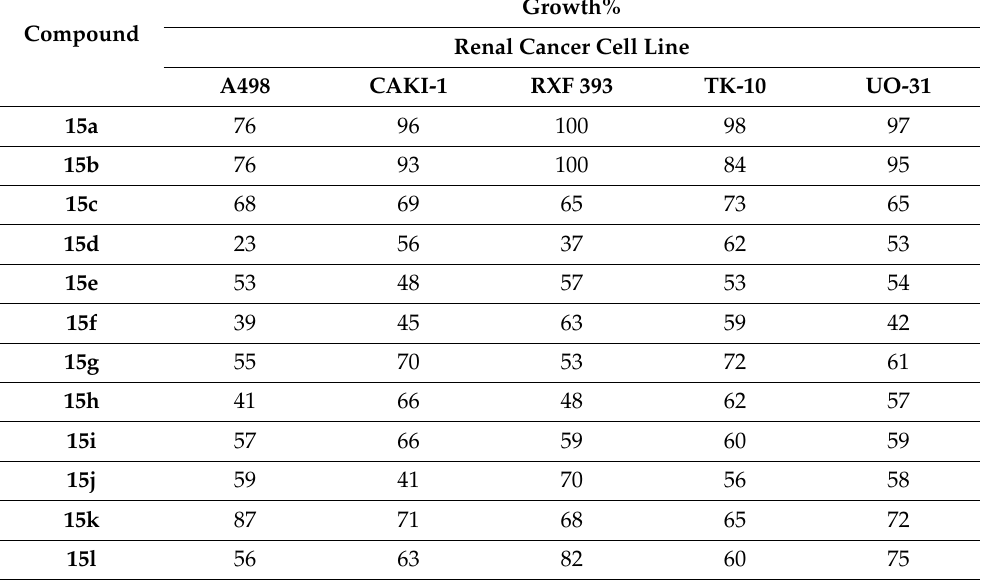
Table 4. Growth % of NCI renal cancer cell lines treated with tested compounds ( 15a–l